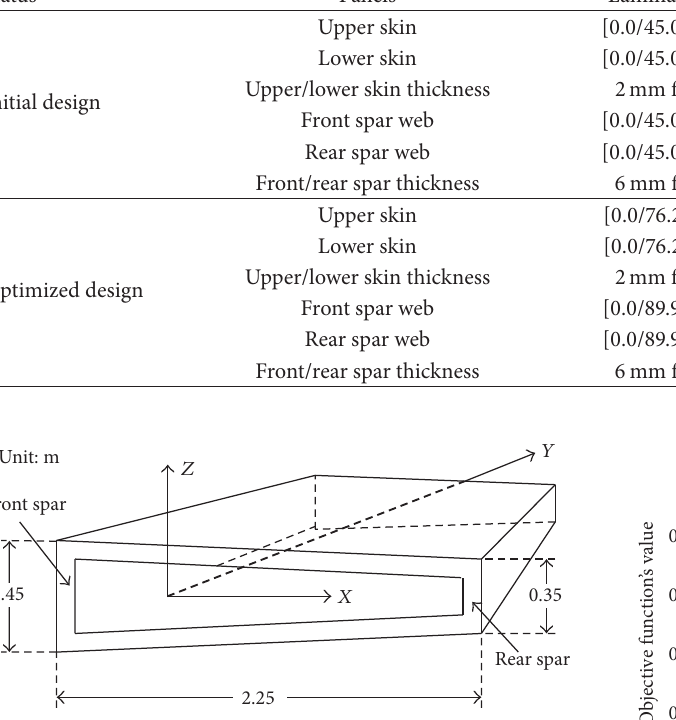
Figure 5: Cross section details of a wing-box beam element.